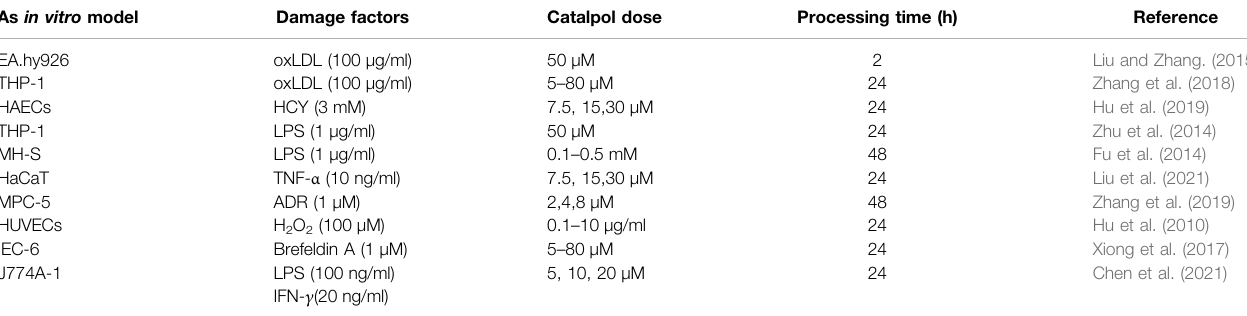
TABLE 2 | Different cell models were used to explore the potential mechanism of catalpol in improving AS. As in vitro